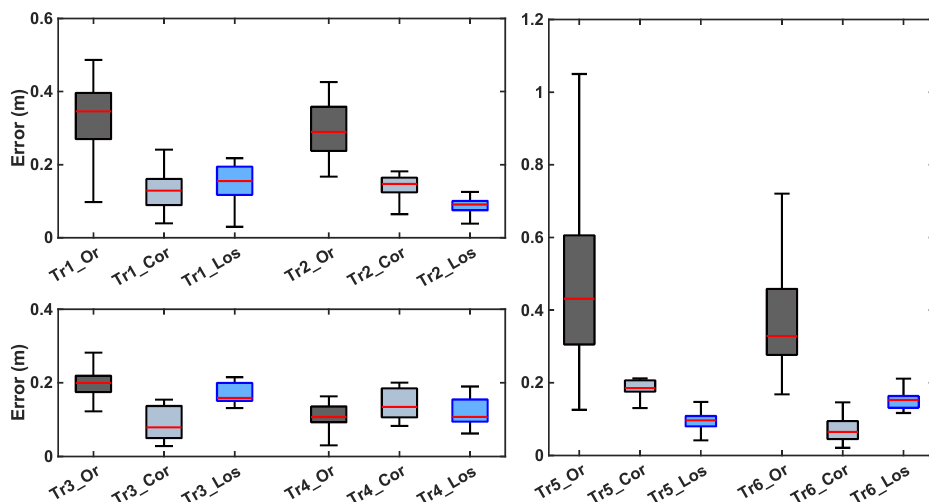
Figure 13. NLOS error distribution before (dark grey boxes) and after the correction (light grey boxes) for the six different trajectories. The light blue boxes represent the error for the LOS points. For the graph clarity, the 6 trajectories have been divided into three subplots with different ranges. Starting from the top left, counterclockwise, are shown the error distributions of the trajectories from one to six, which correspond to the ones in Figure 12 from